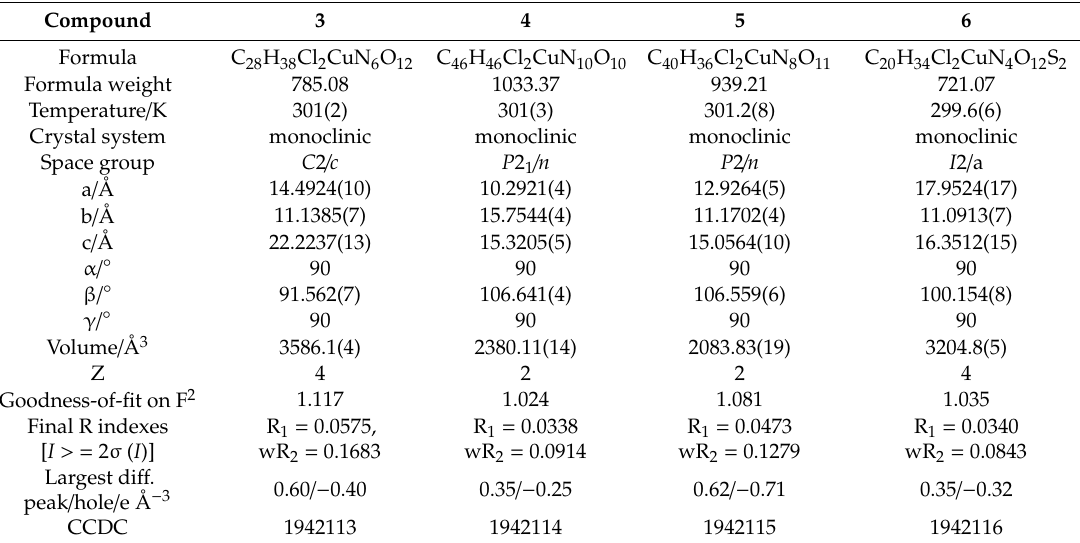
Table 1. Crystal data and structures